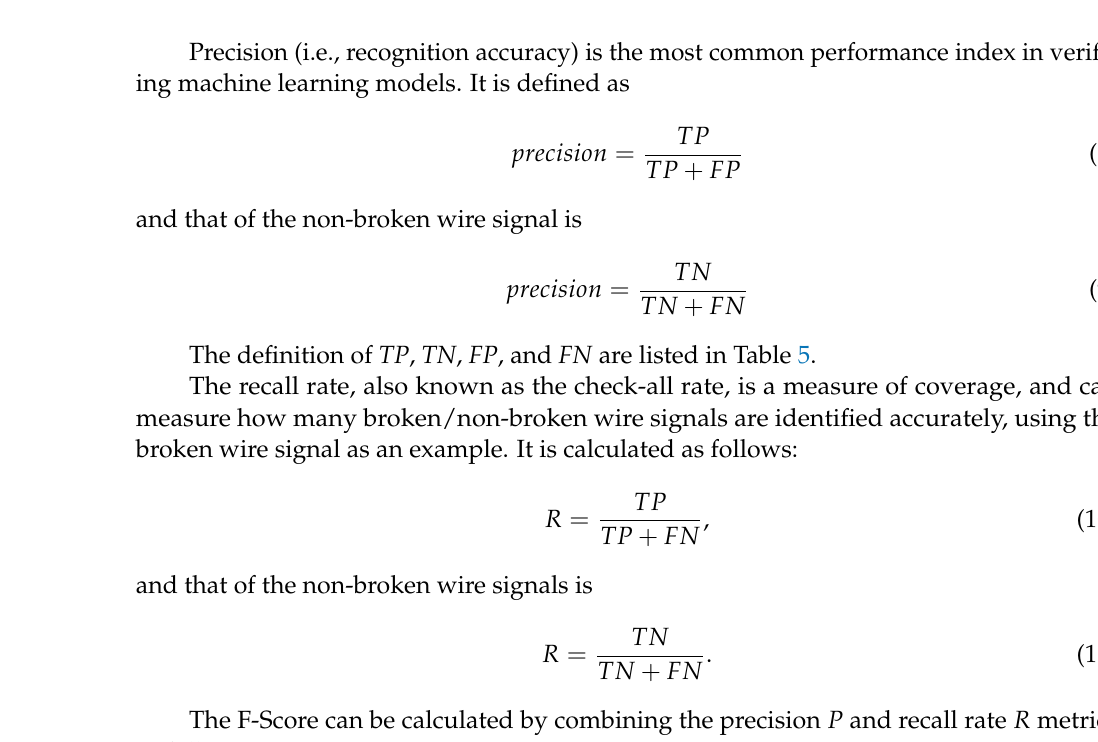
Table 5. Confusion matrix. Prediction of Broken Wire Signal (Positive) Measure broken wire signal (positive) TP (true positive) FN (false negative) Measured non-broken wire signal